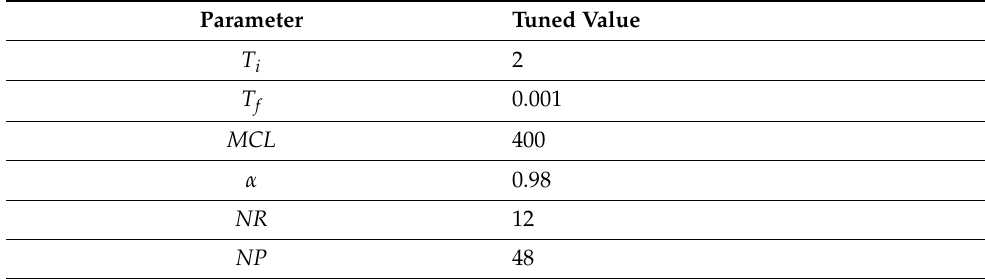
Table 3. Tuned simulated annealing